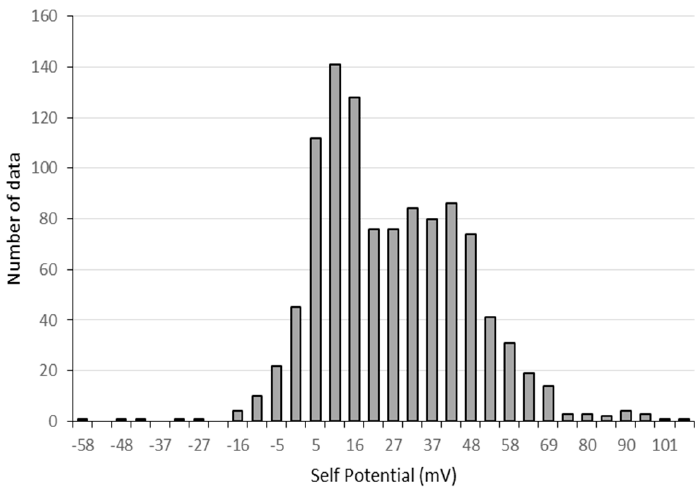
Figure 4. Bimodal histogram of the self-potential values distribution.